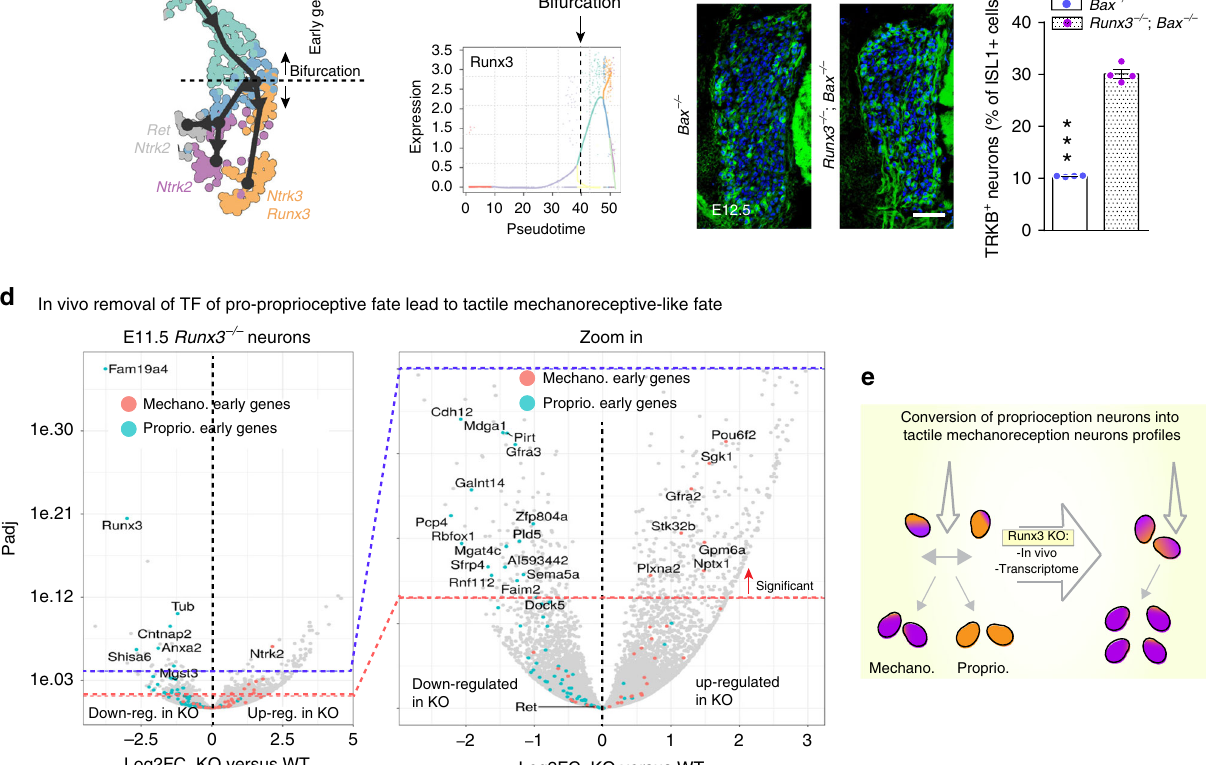
Fig. 5 Early branch-speci fi c gene RUNX3 as a key player for fate biasing before split decision. a Bifurcation analyzed. b Pseudotime of Runx3 along the trajectories show that Runx3 is upregulated in cells before the bifurcation point. Colors encode branches, as in Fig. 4a. c DRG sections from Runx3 + / + ; Bax − / − and Runx3 − / − ; Bax − / − E12.5 embryos ( n = 4) stained for TRKB and ISL1 reveal a threefold increase in the number of TRKB + neurons in the absence of Runx3 . Scale bar, 50 µ m. *** P < 0.0001. Data are presented as mean values ± SEM. d Volcano plots of differentially expressed genes between Runx3 + /GFP and Runx3 GFP/GFP DRG neurons (E11.5) showing downregulation of genes that belong to early genes modules of the proprioceptor trajectory and upregulation of genes that belong to the early genes modules of the mechanoreceptors trajectory. e Scheme recapitulating the fi